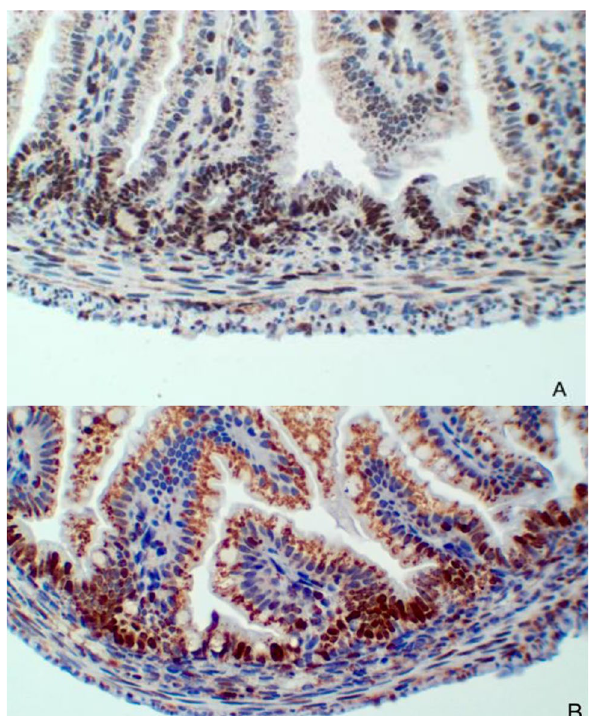
Figure 6. Immunohistochemical analysis of Ki-67. ( A ) Group submitted to the NEC protocol—Reduction of the percentage of brown nuclei cells (Ki-67 stained) in relation to the total number of cells in the proliferative zone of the intestinal mucosa. ( B ) Negative control group—Higher percentage of brown nuclei cells (Ki-67 stained) in relation to the total number of cells in the proliferative zone of the intestinal